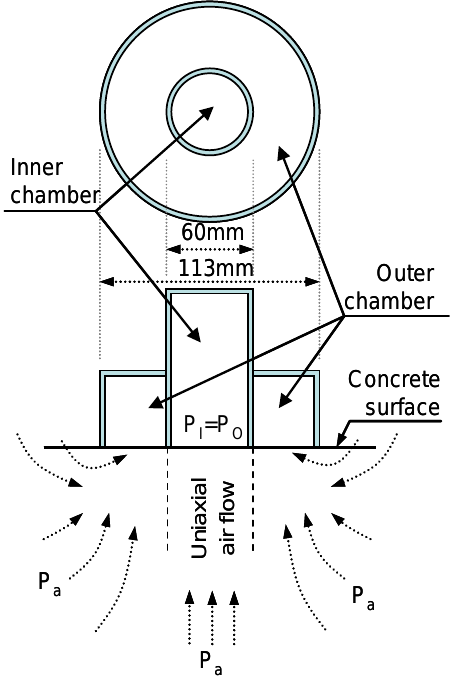
Figure 4. Conceptual diagram of the chamber and air flow.